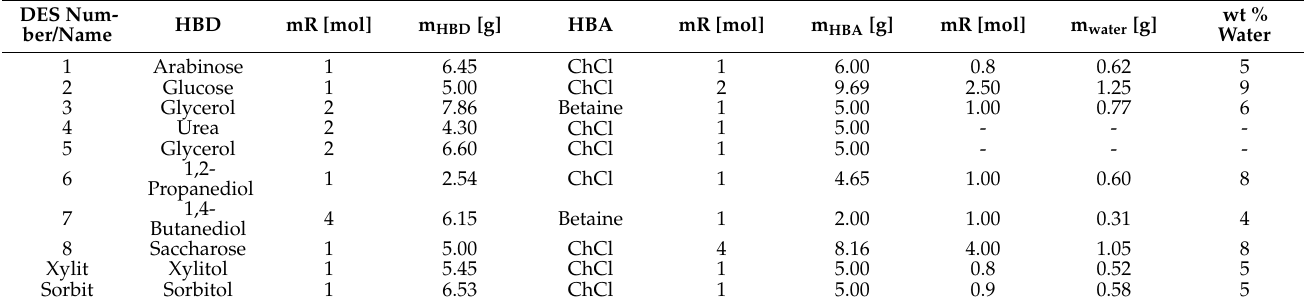
Table 1. Composition of common and sugar alcohol-based DESs